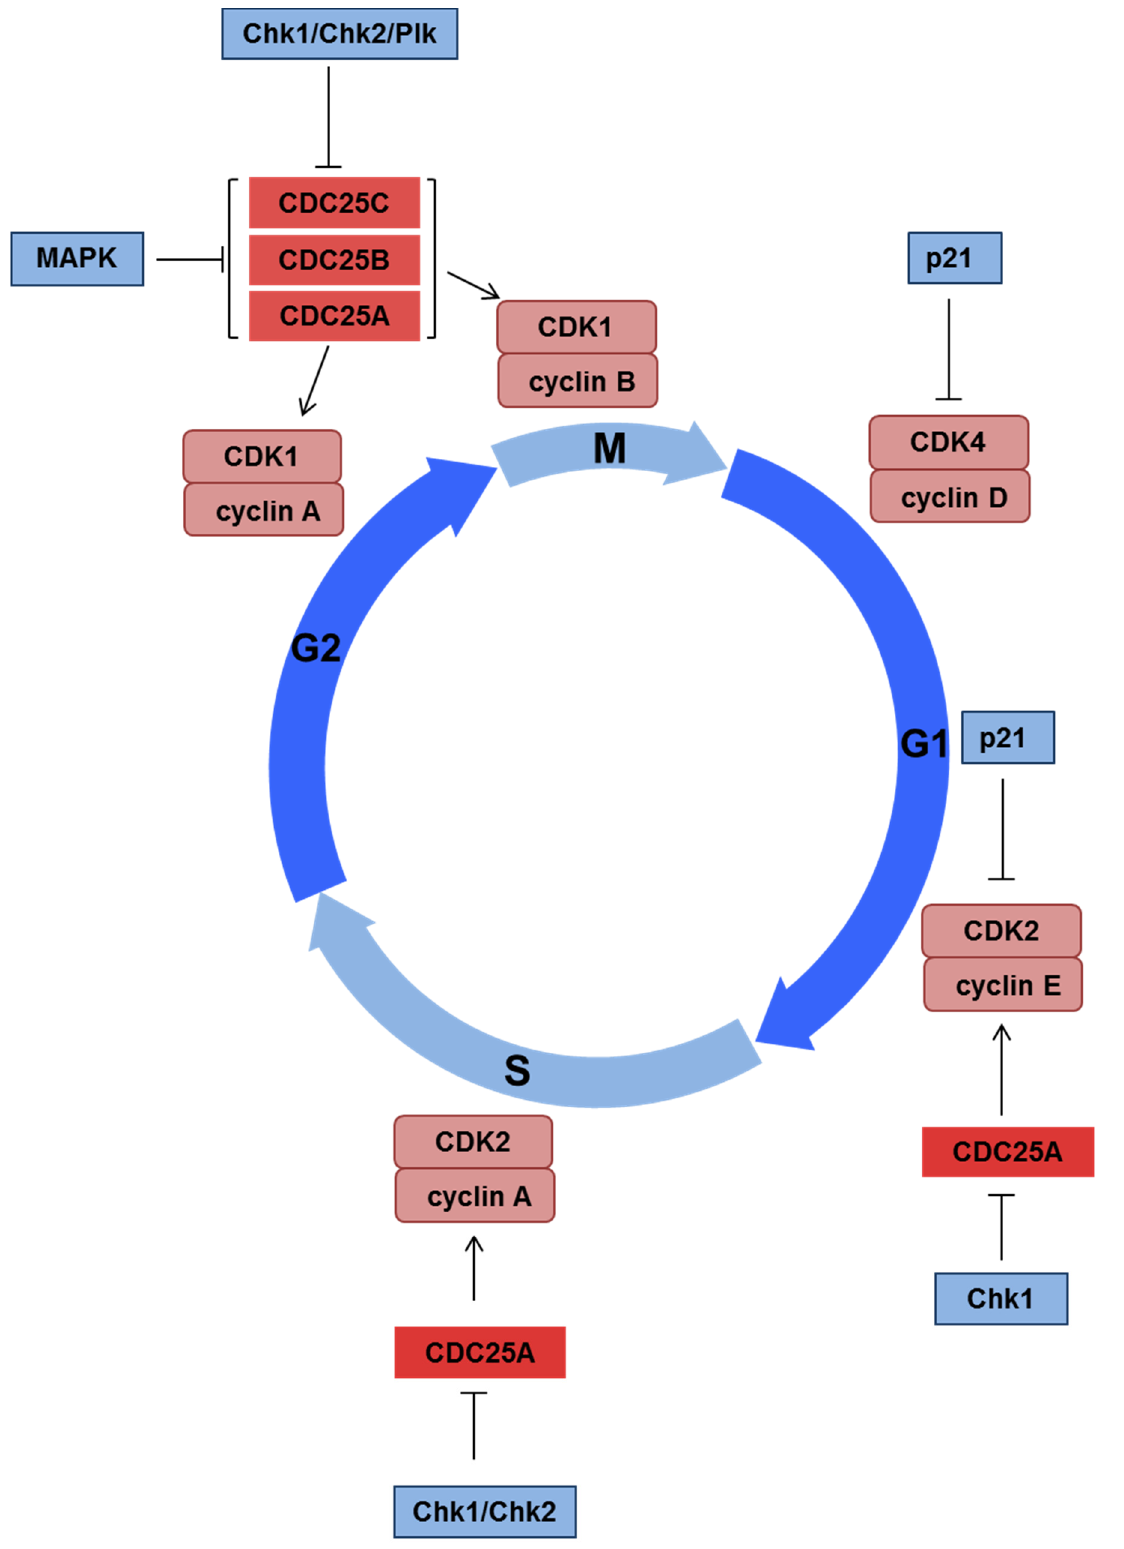
Figure 3. Regulation of the cell cycle by cyclins and CDKs. In response to DNA damage phosphorylation of CHK1 and CHK2 can lead to degradation of Cdc25 phosphatases. Cdc25 degradation inhibits activation of CDKs and delays progression of the cell cycle. Increased expression of p21 by p53 following DNA damage can also mediate cell cycle arrest through inhibition of